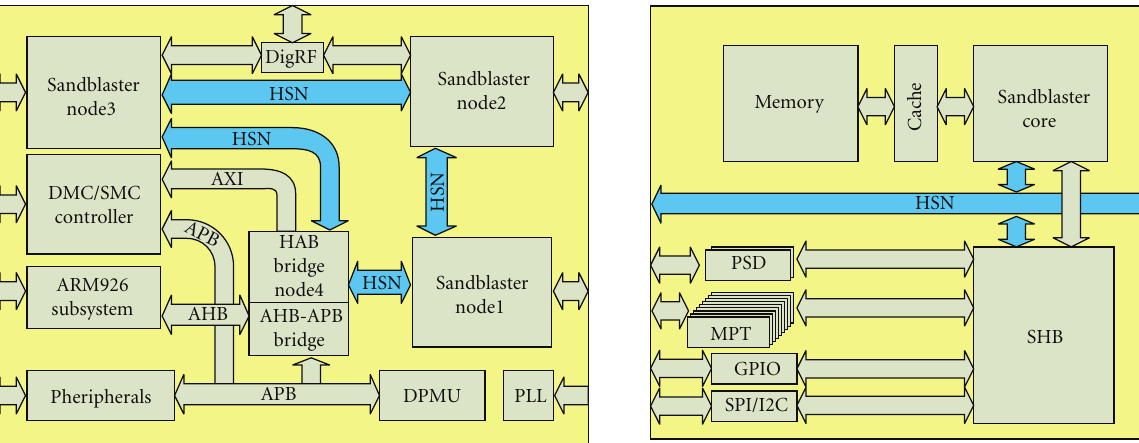
Figure 2: The simplified structure of SB3500. Figure 3: The SBX node block